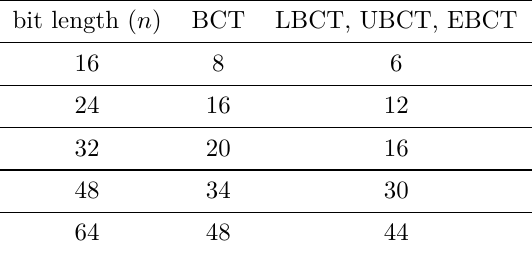
Table 2: Initial values of k lb